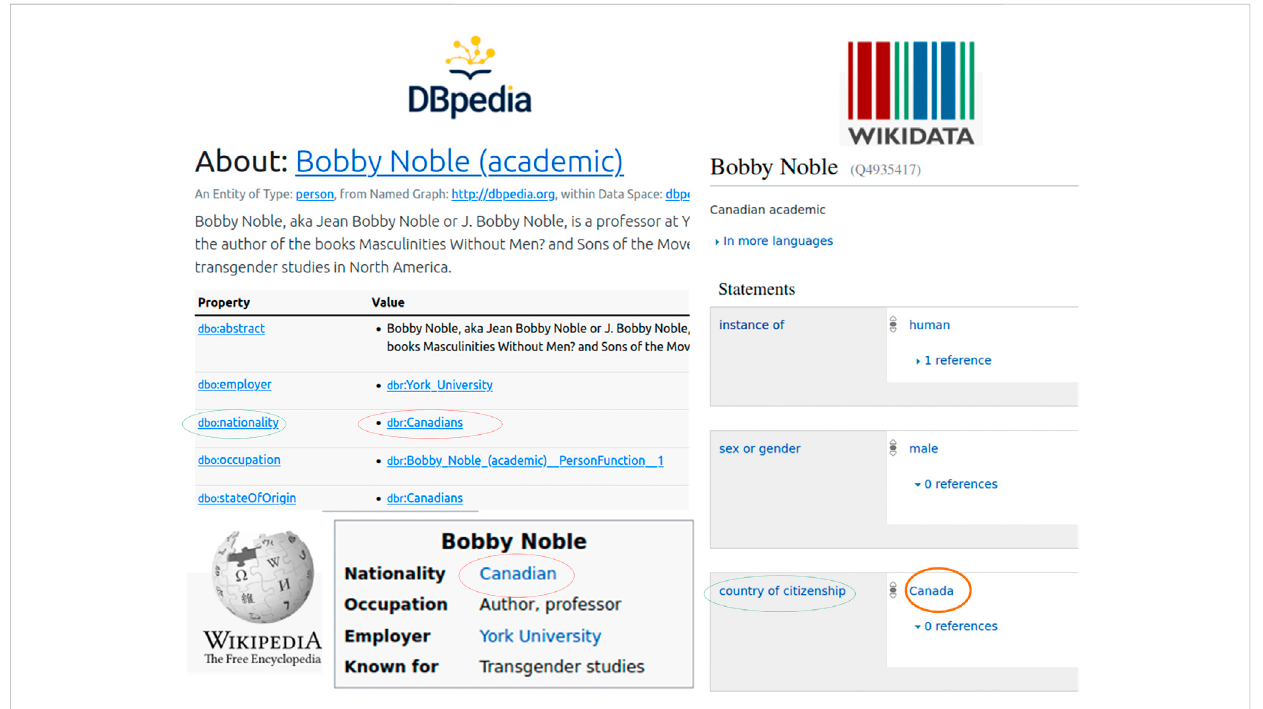
FIGURE 3 Structured information about Bobby Noble